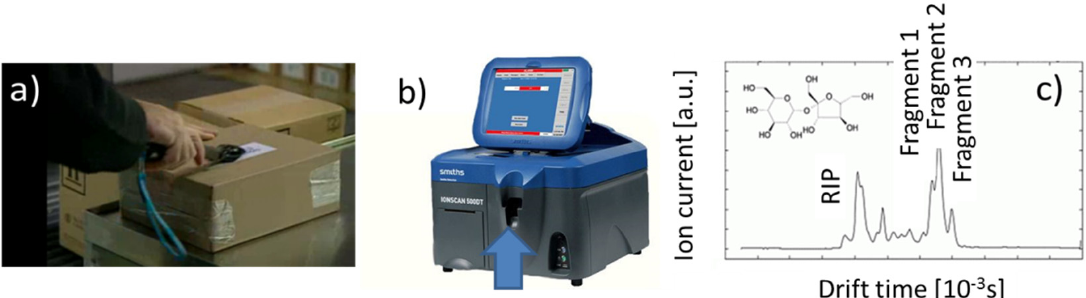
Figure 6. ( a ) Collecting trace particle residue from a suspect item using the IonScan 500 sampler “spoon”; ( b ) IonScan 500 ion mobility spectrometer (IMS) with the insertion port for the sampler spoon (arrow) [34]; ( c ) example of ion drift spectrum. Table 4. Properties of state ‐ of ‐ the ‐ art IMS